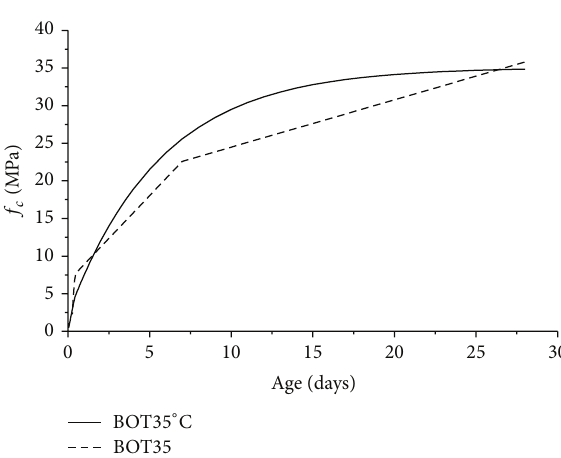
Figure 5: Simulated and experimental strength development curves of heat treated sand concrete at 35 ∘ C.